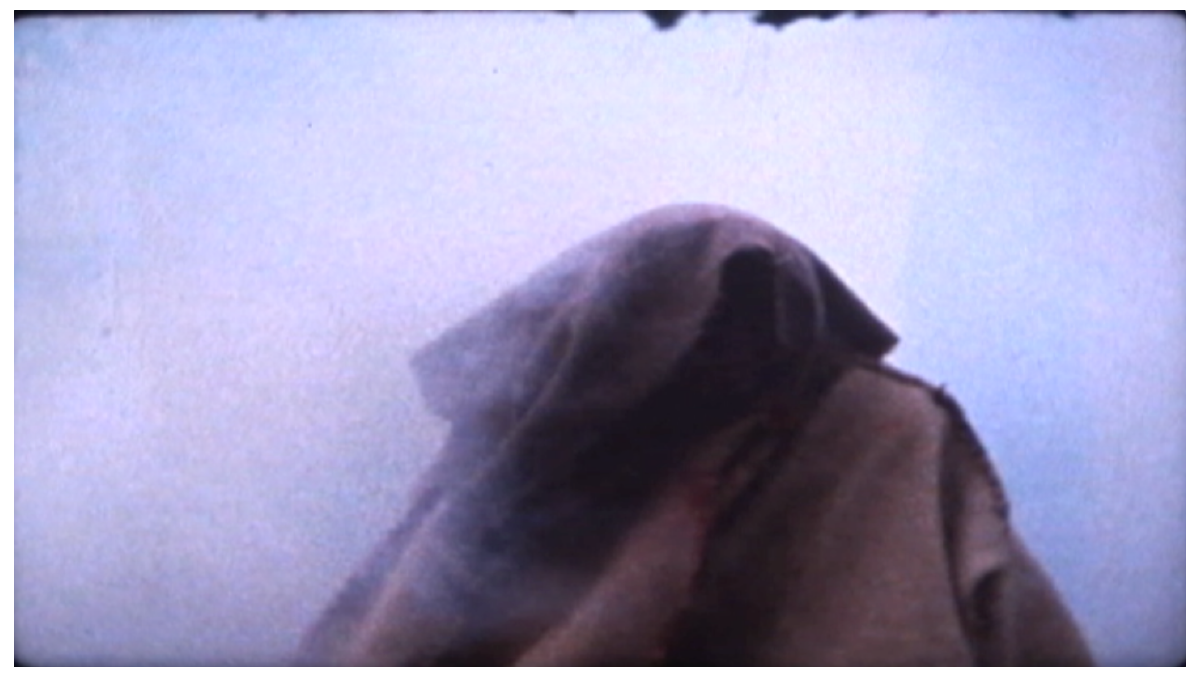
Figure 4: Still from Francisco Huichaqueo Pérez’s Mencer: Ñi Pewma (2011) Video still courtesy of Francisco Huichaqueo Pérez. Film available at: https://vimeo.com/